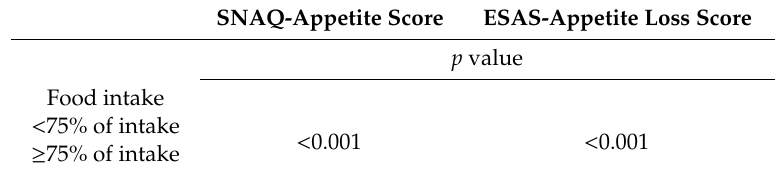
Table 3. Association between food intake and appetite scores in total population ( n =